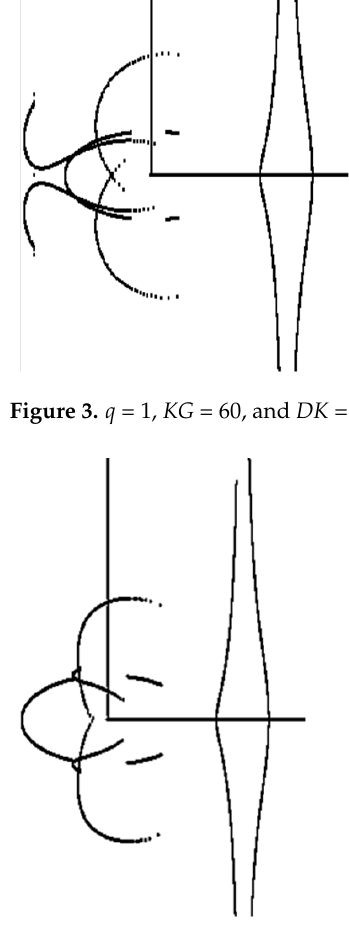
Figure 5. q = 1, KG = 100, and DK = 140.